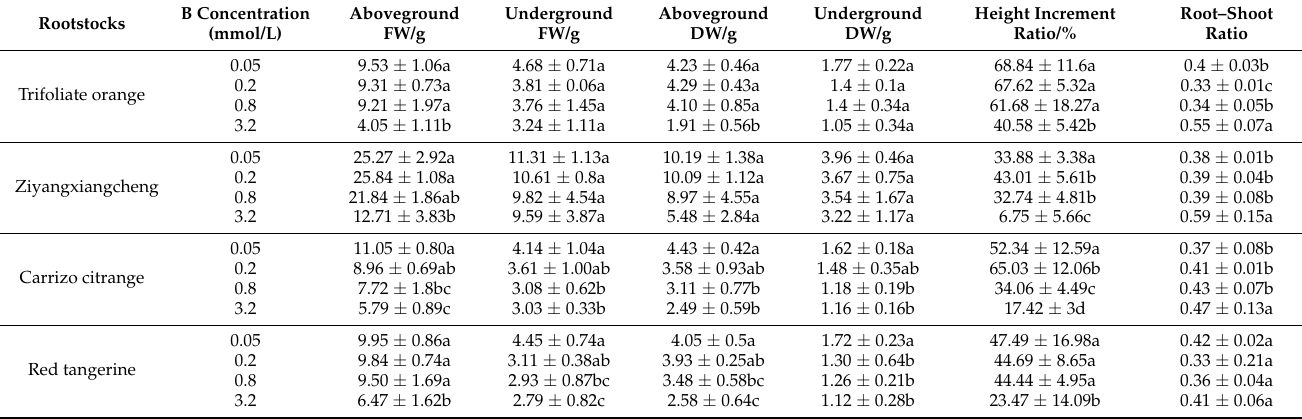
Table 3. The impact of excess B stress on the fresh weight, dry weight, height increment ratio, and root–shoot ratio of four citrus rootstock